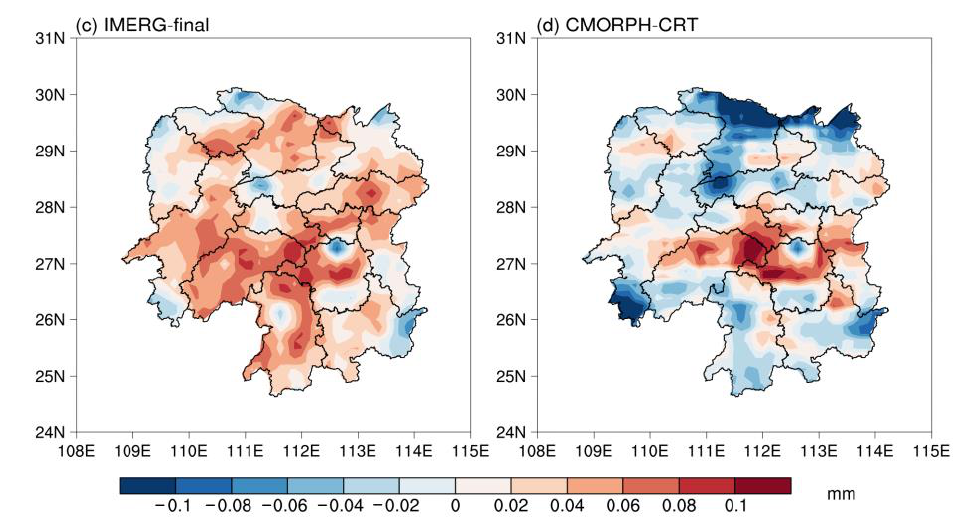
Figure 3. Spatial distribution of the mean error at 3-hourly time scale.